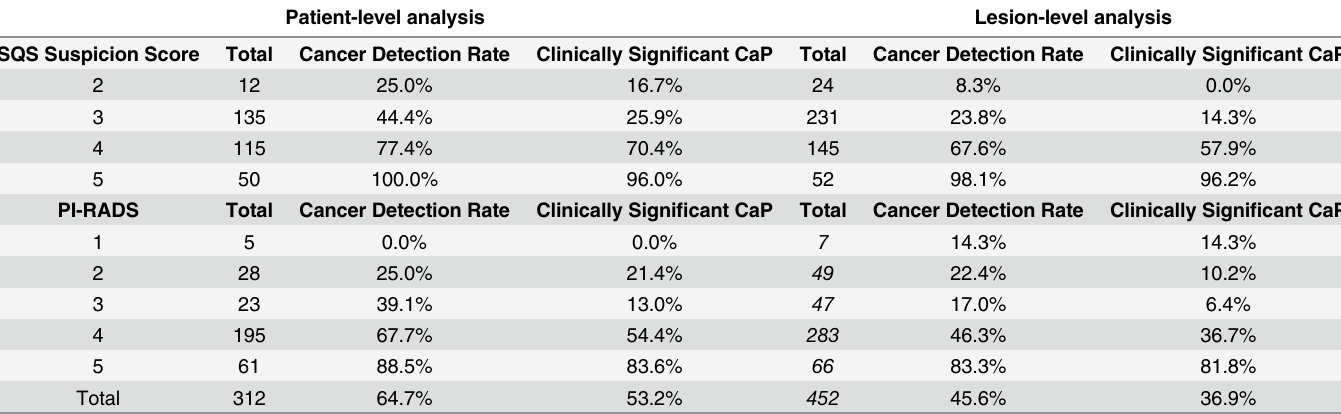
Table 1. Cancer detection rates for prostate cancer and clinically significant prostate cancer stratified by scoring